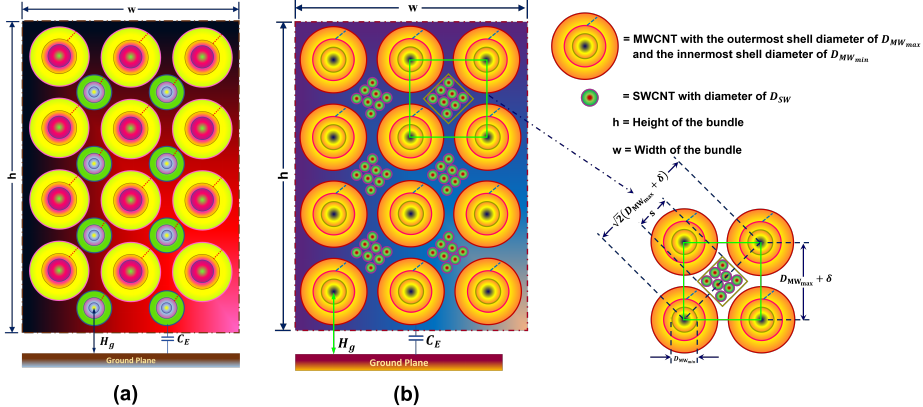
Figure 1. ( a , b ) In both architectures, the size of the larger MWCNTs are the same. The main modification happened in the introduced configuration by means of smaller MWCNTs replaced by a bunch of SWCNTs with the same predefined diameter, according to the space available based on the technology